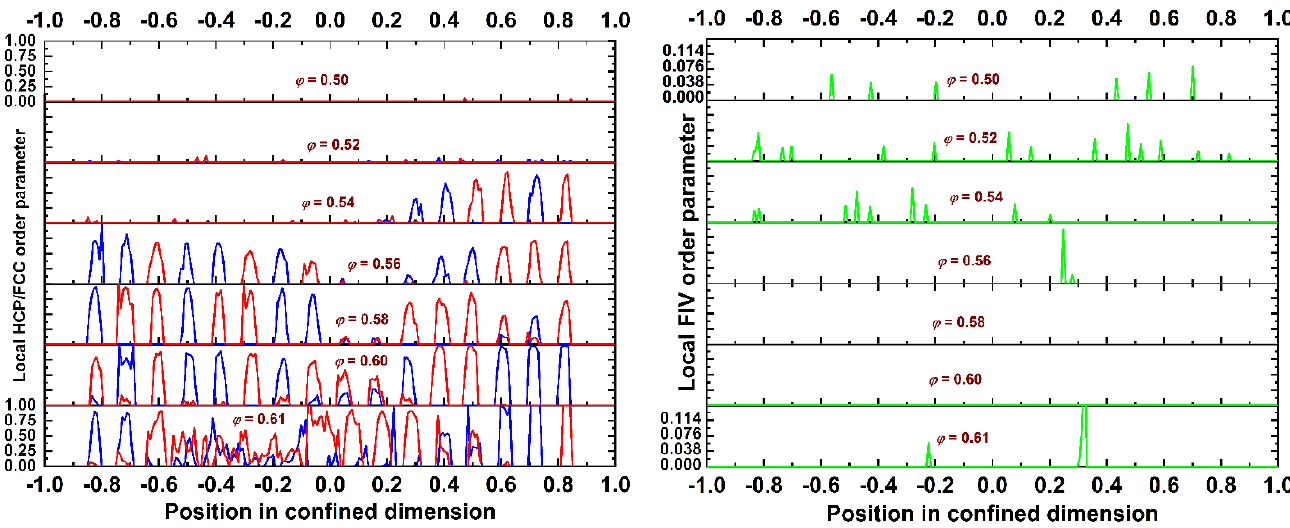
Figure 9. Stacked plots of the local ( left panel ) HCP/FCC and ( right panel ) FIV order parameter, as calculated from the CCE norm, as a function of position in the confined dimension for the N = 100 system. Different plots correspond to different packing densities. Blue, red, and green correspond to the HCP, FCC, and FIV order parameters, respectively.